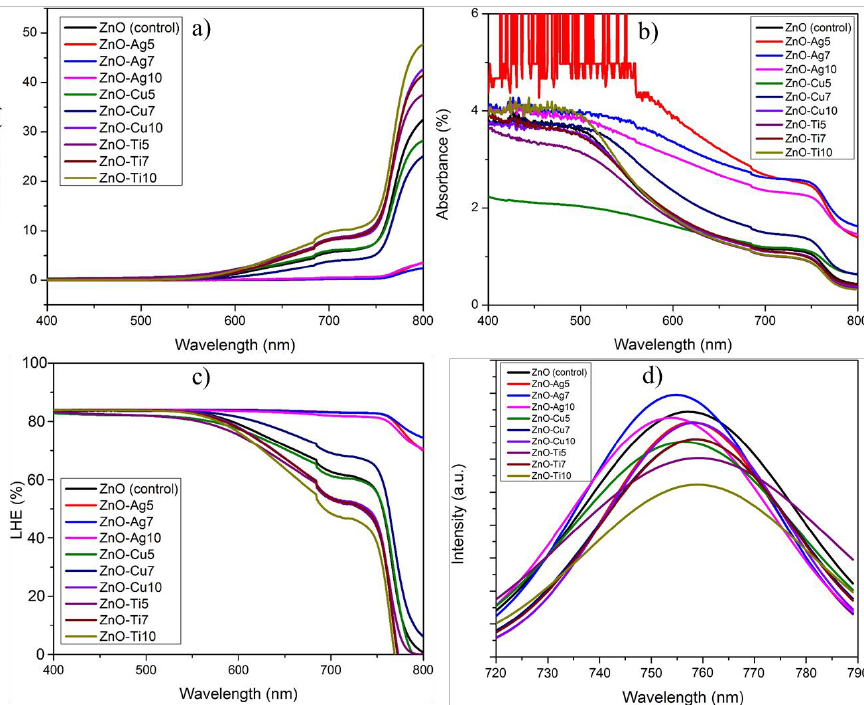
Figure 6. ZnO (Ag, Cu, and Ti) coated with perovskite depicting ( a ) reflectance, ( b ) absorbance, ( c ) LHE, and ( d ) steady-state photoluminescence. ( c ) LHE, and ( d ) steady-state